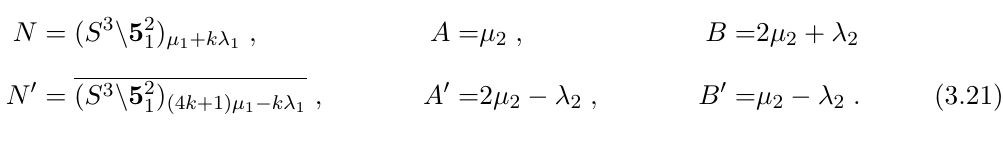
Figure 5 . A rational surgery calculus [41] shows that ( S 3 n 5 2 example, K k =1 = 4 1 ; K k = (cid:0) 2 = 5 2 and K k =2 = 6 1